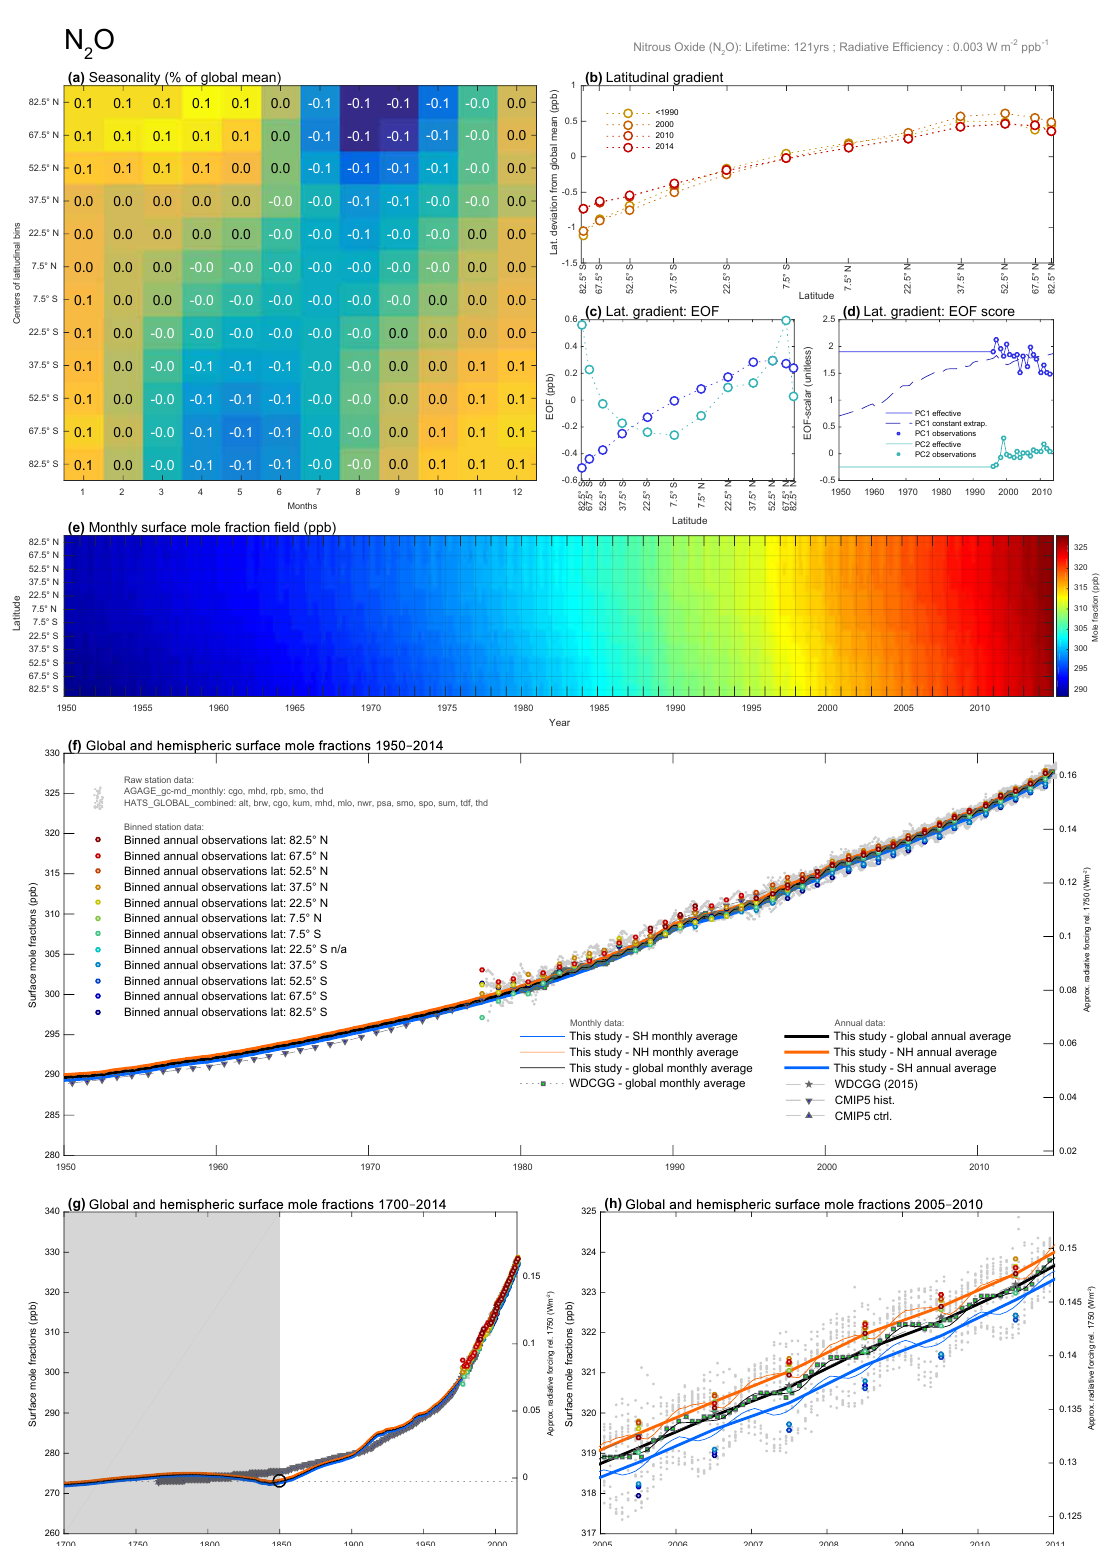
Figure 12. Overview over historical N 2 O concentrations. As Fig. 11, but for N 2